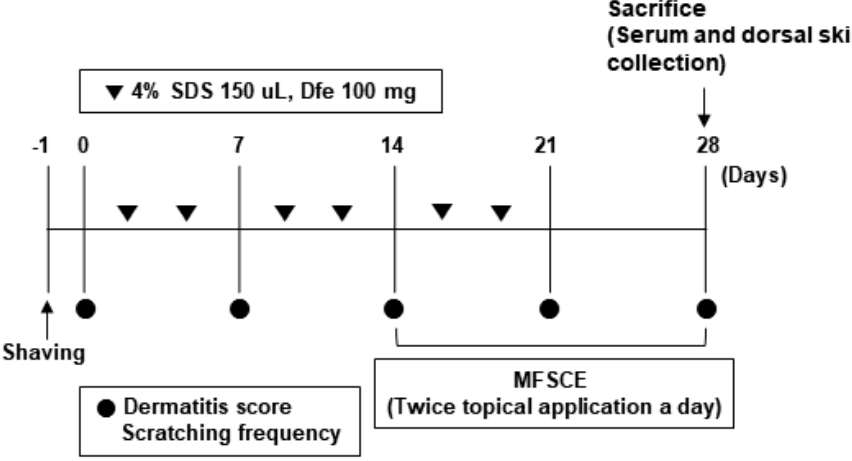
Figure 1. Schedule of induction and treatment for AD-like skin inflammation in NC/Nga mice. SDS: sodium dodecyl sulfate, Dfe: Dermatophagoides farinae extract, MFSCE: membrane-free stem cell ex- tract.